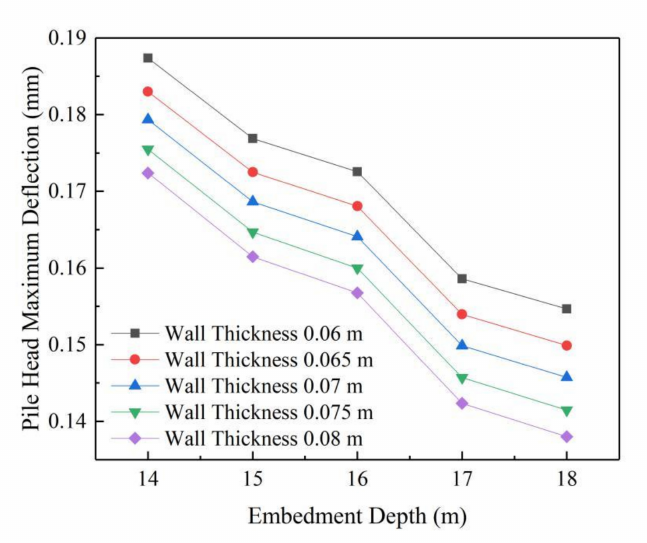
Figure 11. Influence of pile diameter and embedment depth on maximum